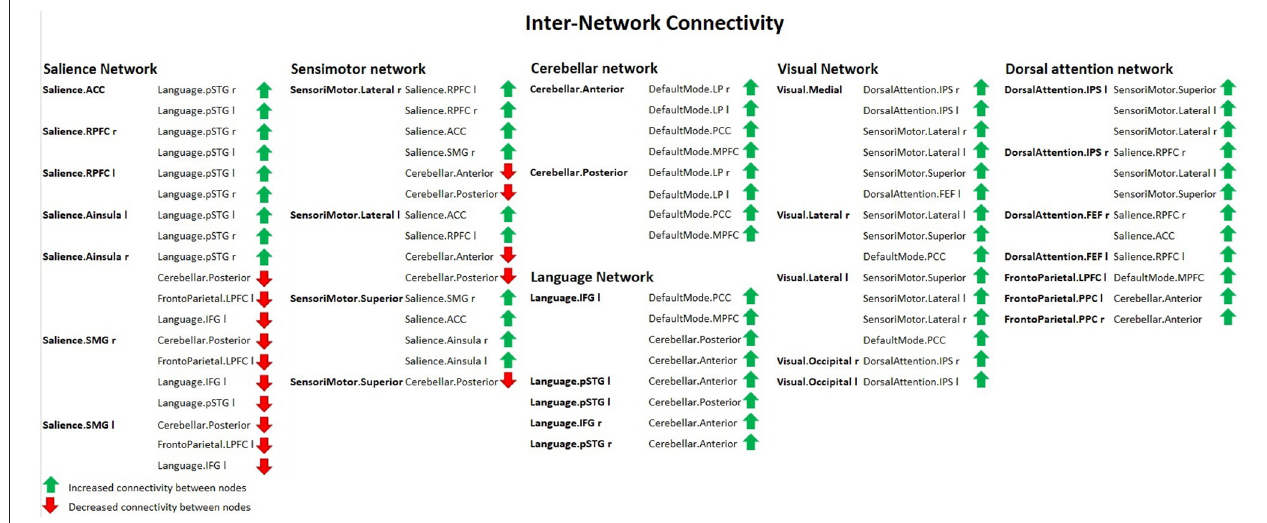
FIGURE 6 | Inter-network connectivity table showing increased (green arrows) or decreased (red arrows) FC between nodes in females with ageing, using spatial pairwise clustering (SPC) method.